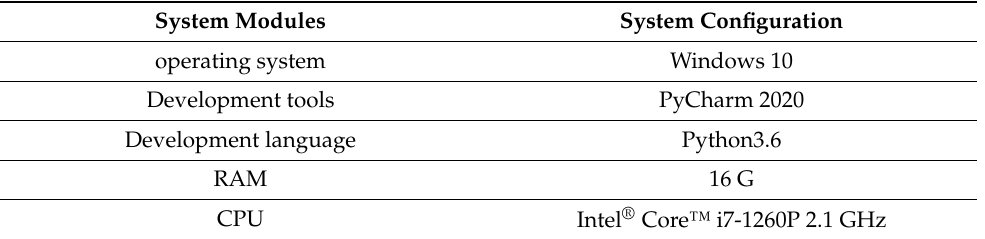
Table 6. Software test hardware platform parameter